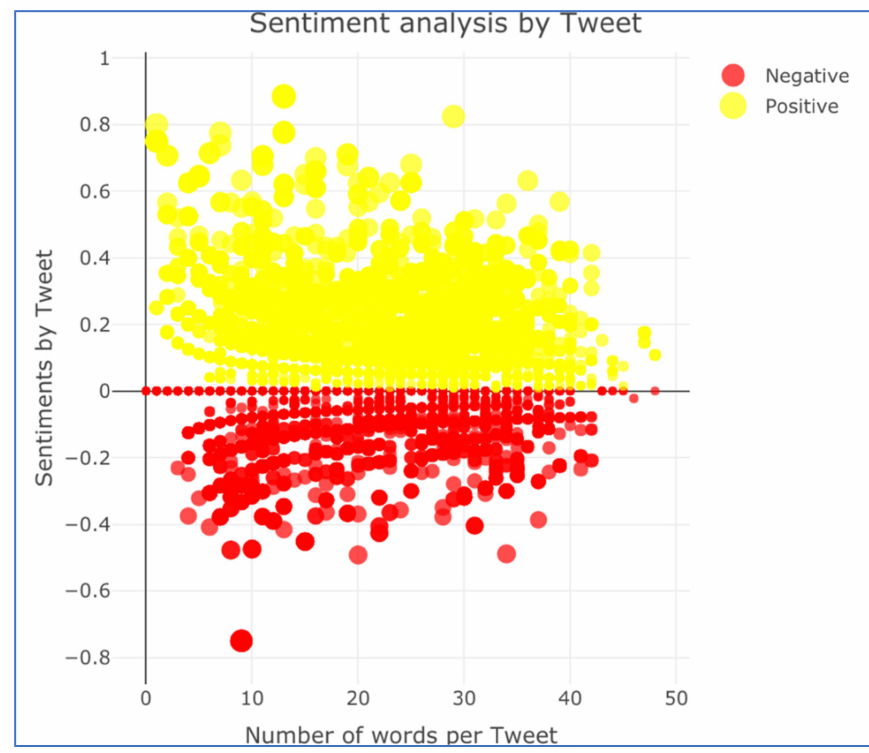
Figure 11. Sentiment analysis by